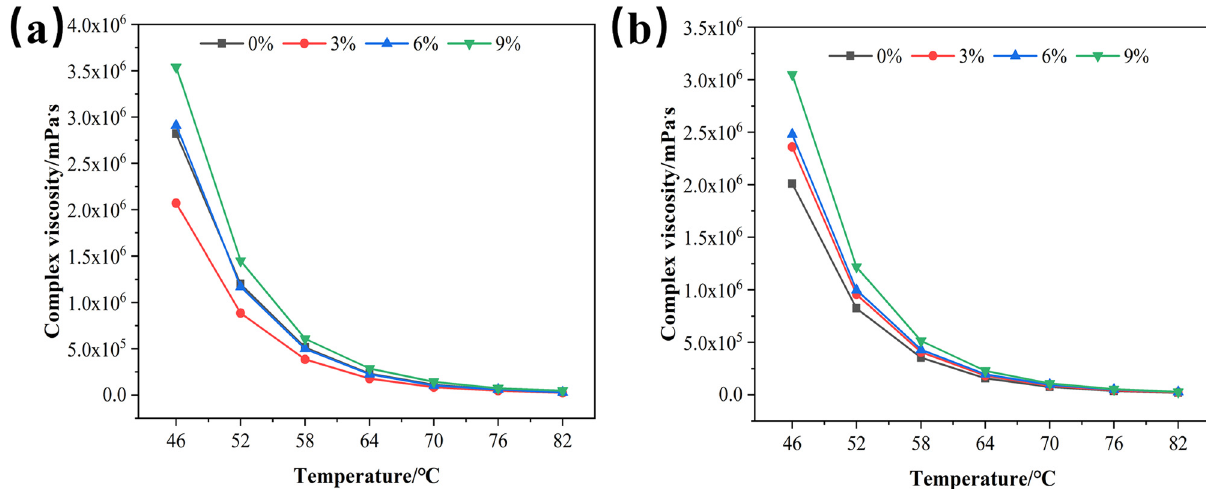
Figure 6: Complex viscosity of temperature sweeping under di ff erent parallel plates: ( a ) complex viscosity under 8 mm parallel plate and ( b ) complex viscosity under 25 mm parallel